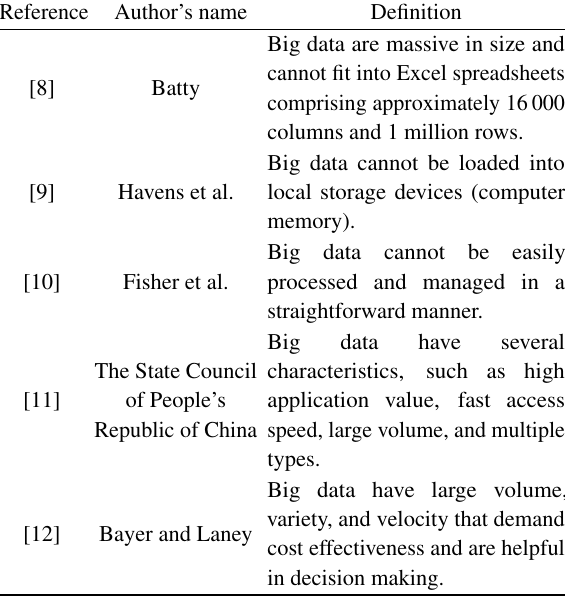
Table 1 Definitions of big data.